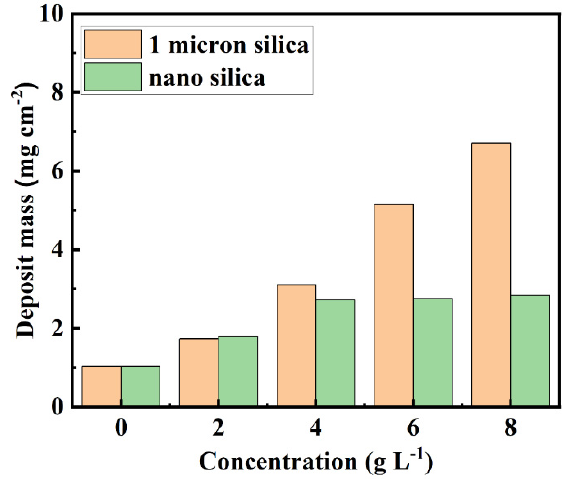
Figure 8. Deposit mass versus silica concentration in 5 g L − 1 PVDF suspension containing 1 g L − 1 GA. Deposition was performed during 5 min at a deposition voltage of 100 V.